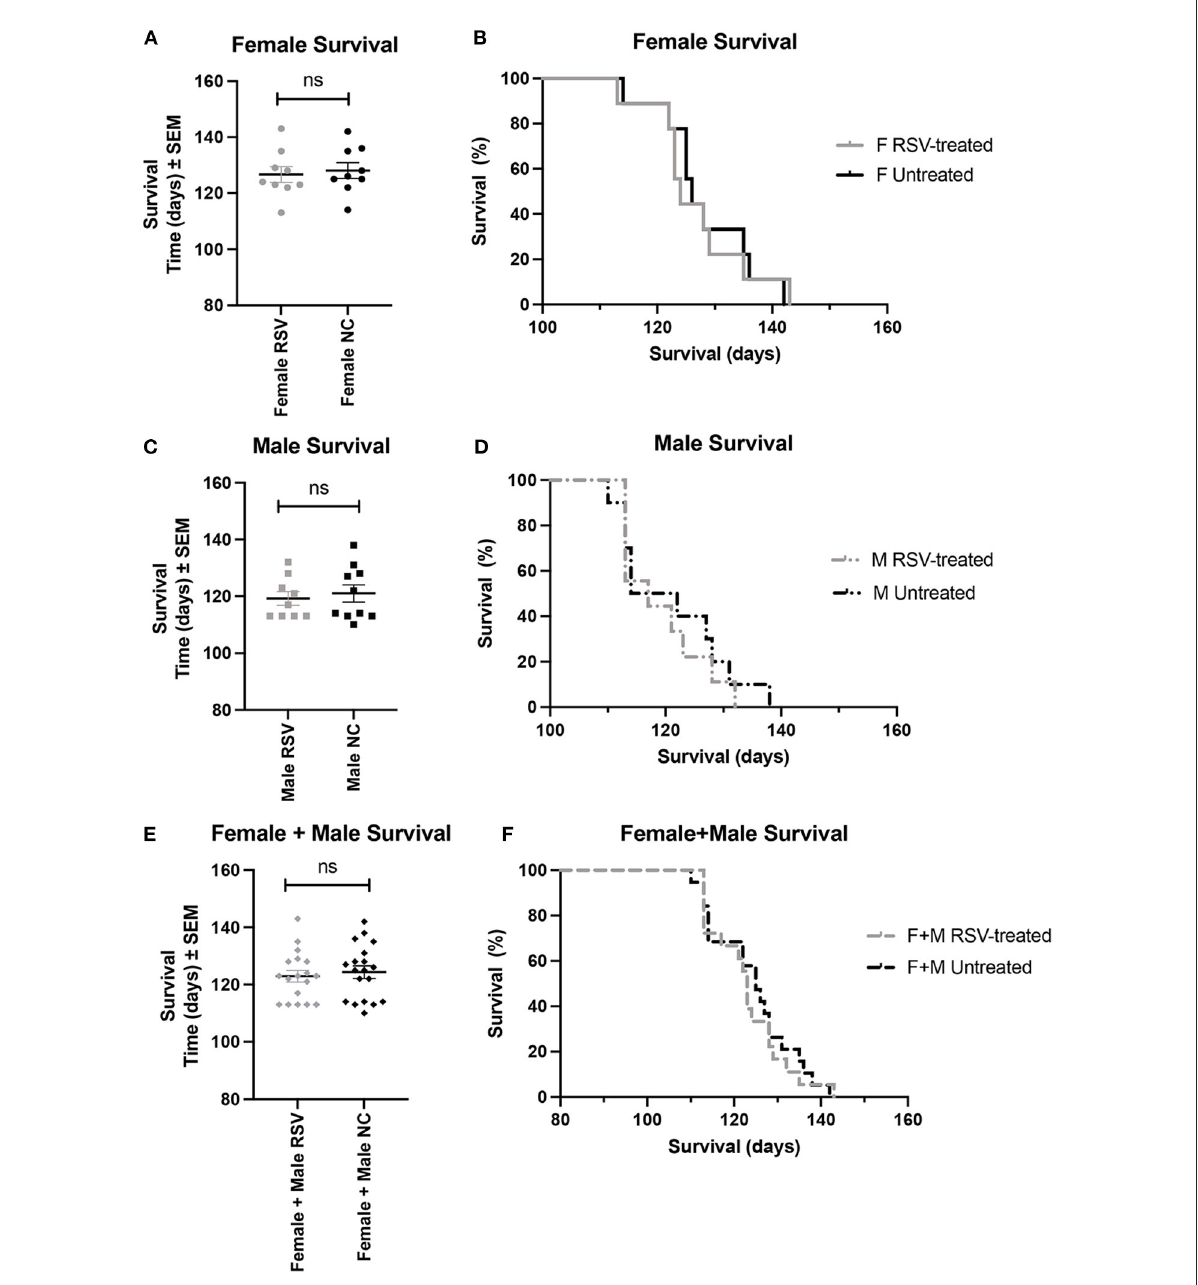
FIGURE2 Scatter plots and Kaplan-Meier curves showing survival for female, male, and combined (female + male) RSV-treated vs. untreated ALS mice. Survival time was determined as the time when the MS = 0 necessitating required euthanasia. (A) Female survival time scatter plot. (B) Female survival time Kaplan-Meier plot. (C) Male survival time scatter plot. (D) Male survival time Kaplan-Meier plot. (E) (Female + male) survival time scatter plot. (F) (Female + male) survival Kaplan-Meier plot. RSV, Resveratrol-treated animals; NC, Untreated animal received normal chow. Data in panels (A, C, E) are expressed as mean ± SEM. ns,